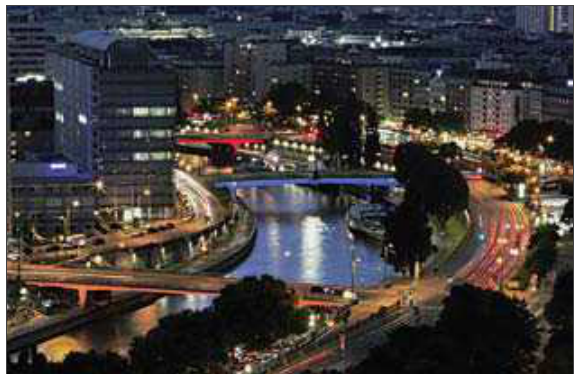
Fig. 19. “Seven screens” by ruri. Videoinstallations